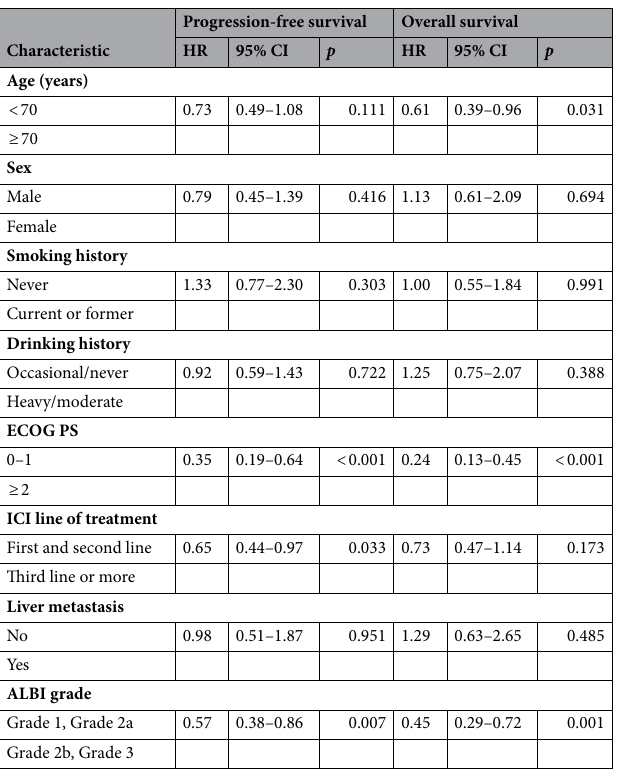
Table 4. Multivariate analysis of clinical variables associated with survival outcomes. HR hazard ratio, CI confidence interval, ECOG PS eastern cooperative oncology group performance status, ALBI grade albumin– bilirubin grade, ICI immune-checkpoint